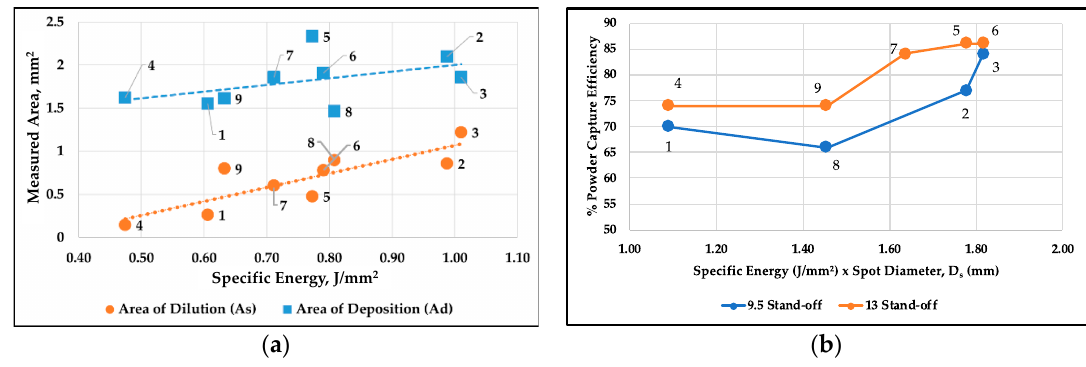
Figure 3. ( a ) Plot of energy input vs. area of deposit (A d ) and area of dilution (A s ); ( b ) plot of % powder capture efficiency vs specific energy x laser spot diameter. Note: numbers adjacent to data-points in ( a , b ) correspond to parameter set numbers summarized in Table 2.